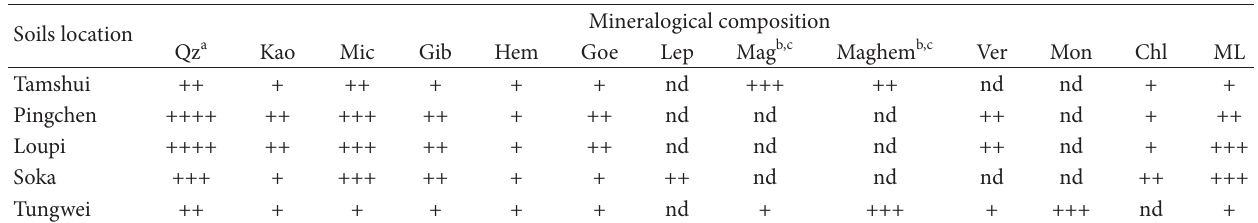
Table 4: Minerals composition in the clay fraction for the five lateritic soils being